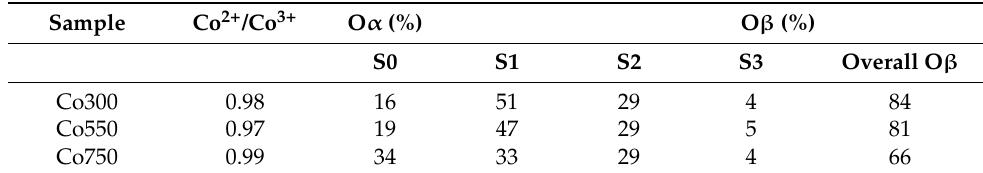
Table 2. XPS results of Co 3 O 4 -based catalysts from the curve fitting analysis of Co2p and O1s core levels.